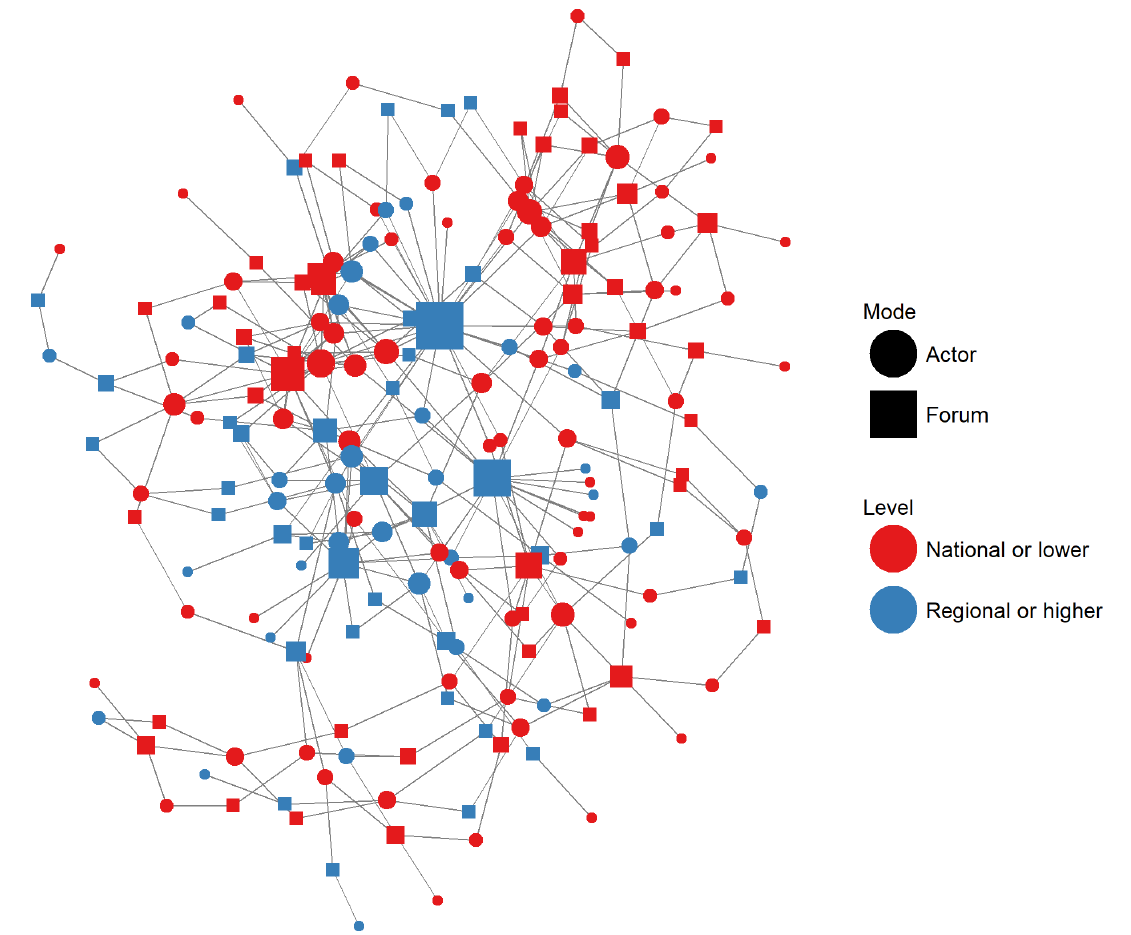
Fig. 3 . Visualization of the Lake Victoria region climate change adaptation policy network. Nodes correspond to actors (circles) and forums (squares), and are colored according to whether they operate at the national or lower level (red) or at the regional or higher level (blue). Linkages represent participation by actors in policy forums. The size of each node is proportionate to the number of linkages to other